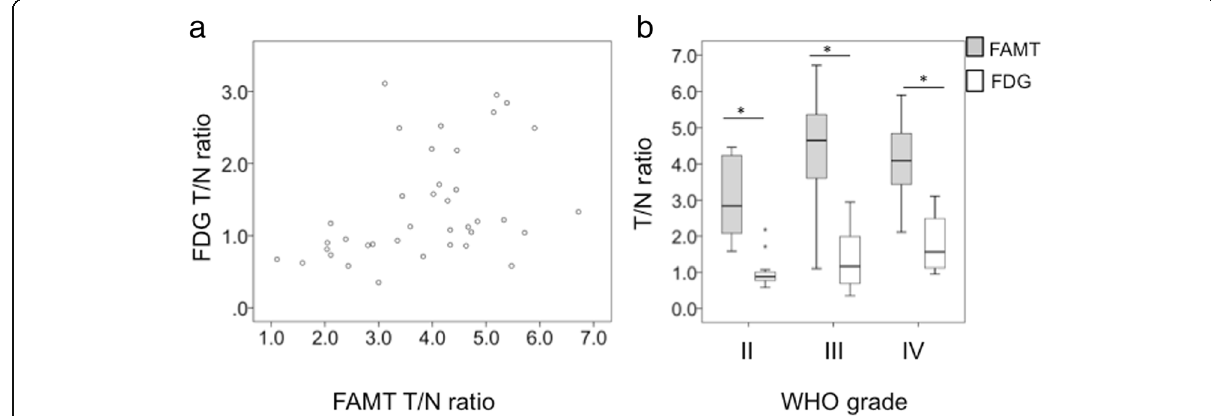
Fig. 4 a Correlation analysis between the T/N ratios of 18 F-FAMT PET and 18 F-FDG PET showed significant positive correlation in all gliomas ( r s =0.430, p <0.01). b Comparison of the T/N ratios of 18 F-FAMT PET and 18 F-FDG PET found significant differences for each WHO grade (all p